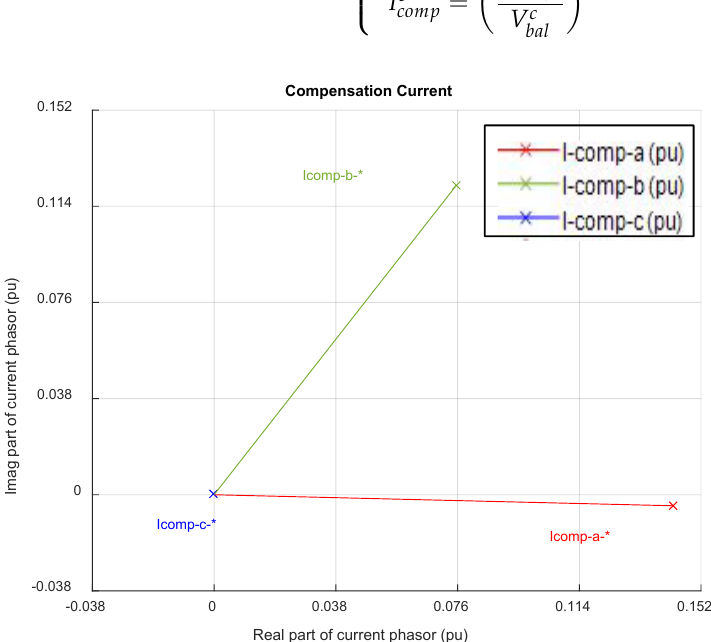
Figure 2. Current phasors compensated by the circuit analysis method. After compensating, the currents of the secondary side of the transformer were bal- anced. The voltages at the secondary side of the transformer became balanced because of the balanced transformer structure and balanced currents. The phasors of the original and compensated voltages are compared in Figure 3. The compensated voltages were 1.003 ∠ − 1.74 ◦ V, 1.003 ∠ − 121.74 ◦ V, and 1.003 ∠ 118.26 ◦ V, which are shown in red, green, and blue color, respectively. The VUF was improved from 10.56% to 0%. Each phase voltage was 1.003, which is similar to a nominal voltage 1.0 pu, and each phase was shifted by 120 ◦ . Table 2 shows the apparent power at the transformer, compensator, and load after compensation. The apparent three-phase power was approximately equal to 0.262 pu. The loads of phases a, b, and c were 0.310, 0214, and 0.262, respectively, equal to 95%, 65%, and 80% of rating power with the same setting value. The compensating power of phases a and b were 0.048 ∠ 0 ◦ and 0.048 ∠ − 180 ◦ , respectively, with the same magnitude but opposite phasor angles. Note that the total apparent power of the compensator was approximately zero for the constraint setting. The zero power represents that no energy was dissipated and developed in the